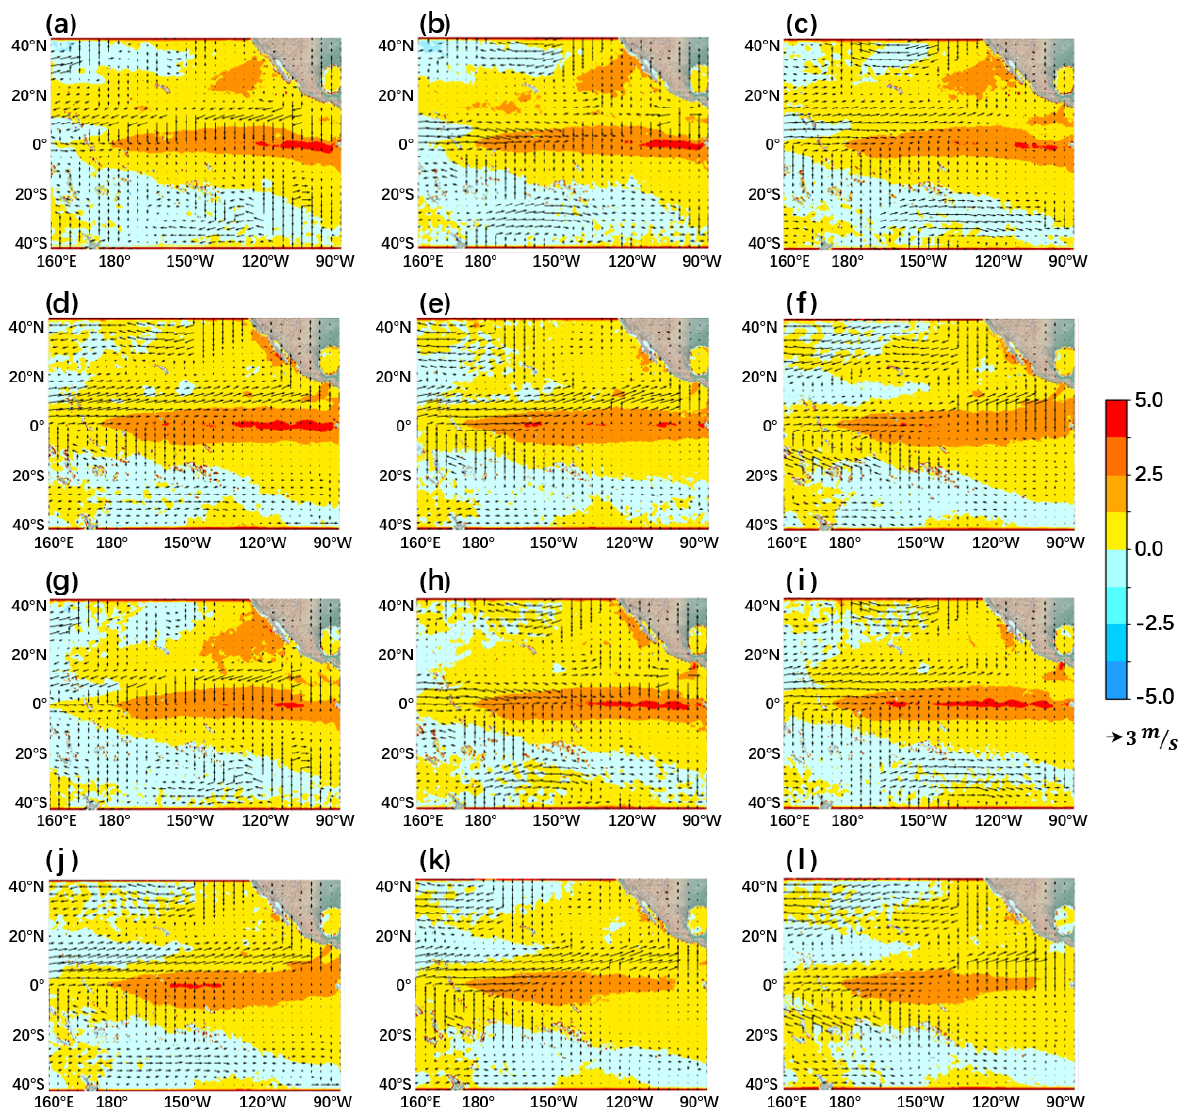
Figure 18. The peak phase of SST and wind anomalies in the 2015–2016 super Niño event from September 2015 to February 2016. Pan- els (a) – (f) show the forecast results of the ENSO-ASC and (g) – (l) show real-world